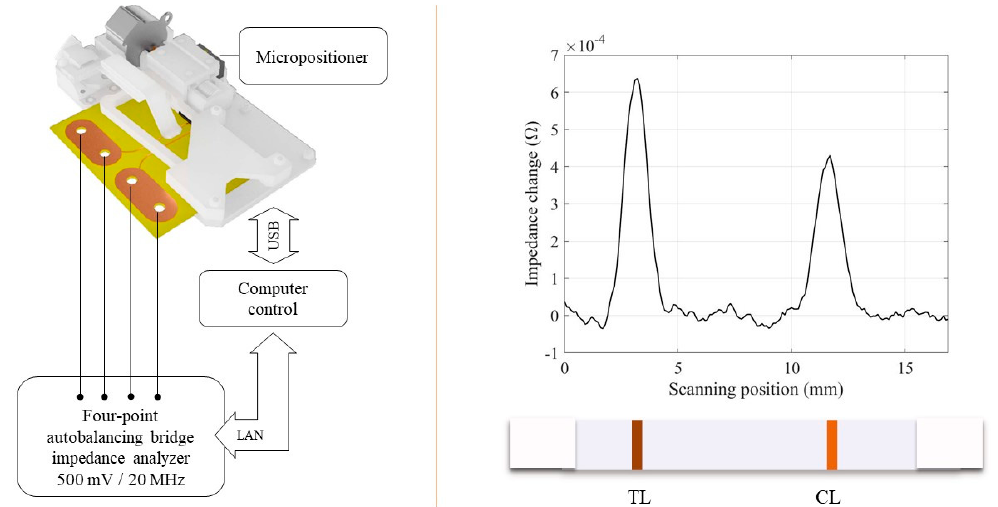
Figure 7. Left : Scheme of the scanning inductive reader for magnetic LFIA. Right : Signal recorded for histamine competitive LFIA (blank sample, competitive immunoassay).